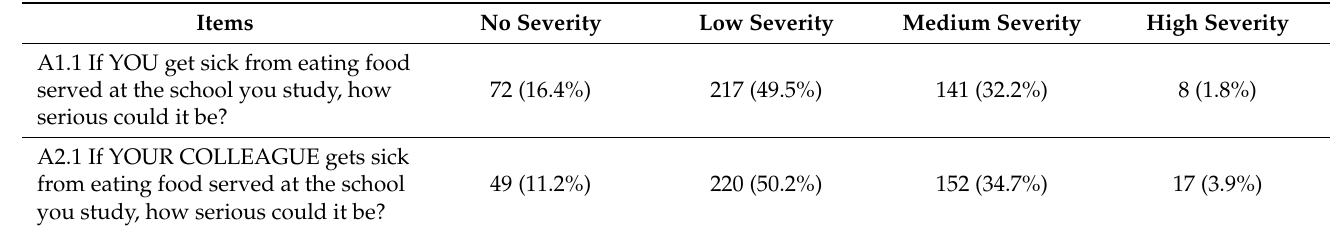
Table 3. Relative and absolute frequencies of responses to the “severity” dimension (A.1 and A2.1) of the risk perception questionnaire.